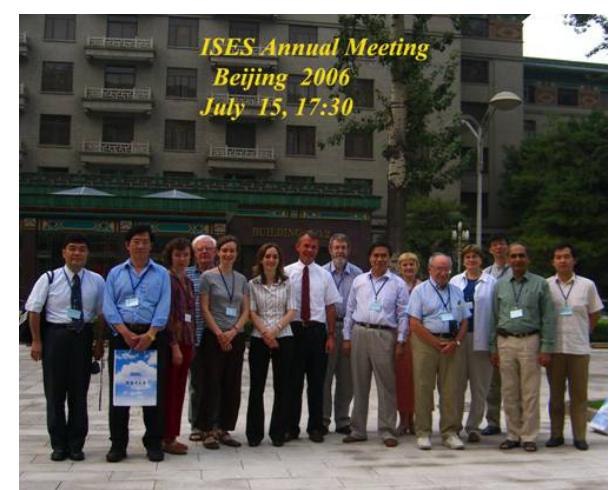
Figure 6. ISES Annual Meeting 2006 at Beijing Friendship Hotel on 15 July